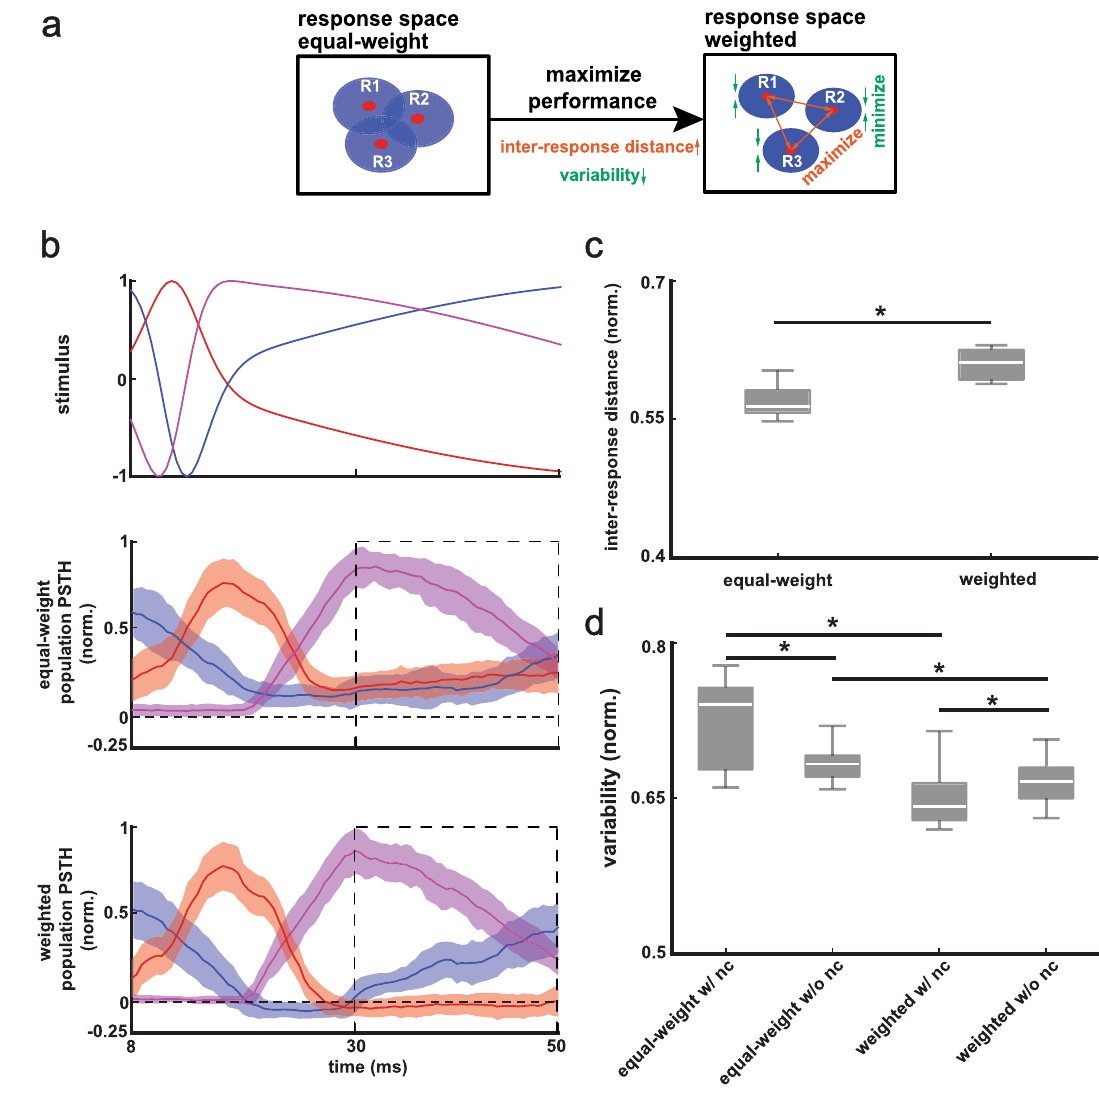
Figure 6. Weighted sums maximized the performance by increasing distances between trials-averaged responses to different stimuli and reducing trial-to-trial variability. ( a ) Schematics showing that weighted sums of neural activities maximize the performance by increasing the inter-response distance (i.e., distances between trials-averaged responses to different stimuli) and reducing response variability. These were created using adobe illustrator CS6 v 16.0 (www. adobe. com). ( b ) Top: three example chirp stimuli. The waveforms are shifted to the right by 8 ms to account for the common synaptic delay of chirp responses. Middle and bottom: the means and standard deviations (shaded areas) of normalized population PSTHs across different trials of the example chirp stimuli under equal-weight and weighted sum. Horizontal dashed line indicates zero. Dashed squares indicate that responses to different stimuli under weighted sum are more different from each other compared to responses under equal-weight sum. ( c ) Boxplots showing that weighted sums of neural activities had higher inter-response distance than equal-weight sums of neural activities (one-way ANOVA, p = 4.5 × 10 –4 ). ( d ) Boxplots showing that weighted sums of neural activities had lower response variability than equal-weight sums of neural activities (with noise correlations, one-way ANOVA, p = 3.9 × 10 –29 ; without noise correlations, one- way ANOVA, p = 3.4 × 10 –17 ); also, equal-weight sums of neural activities without noise correlations had lower response variability than equal-weight sums with noise correlations (one-way ANOVA, p = 3.1 × 10 –9 ) while weighted sums of neural activities without noise correlations had higher response variability than weighted sums with noise correlations (one-way ANOVA, p =